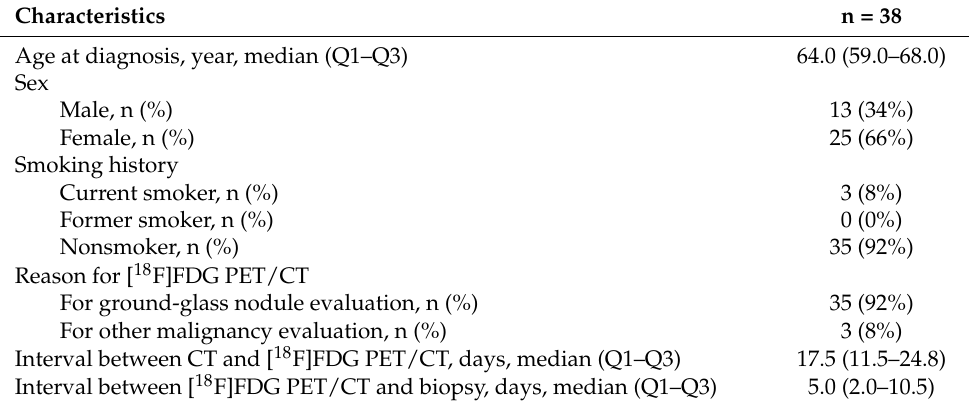
Table 1. Patients’